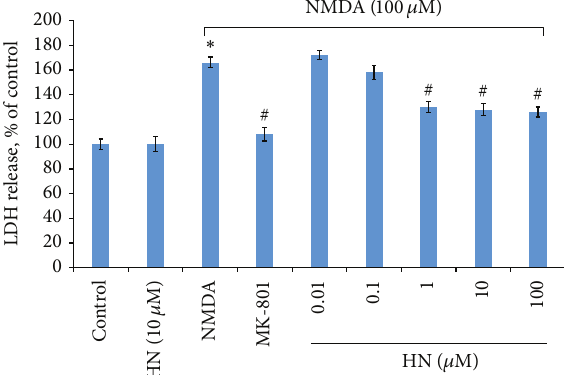
Figure 3: Effect of humanin on NMDA triggered reduction of cell viability in cortical neurons as measured by MTT cell viability assay. Each bar represents mean ± SEM of five independent observations. Statistical significance is at 𝑃 < 0.05 . 𝐹 (8,64) = 2.697 and 𝑃 = 0.013 according to one-way ANOVA analysis. ∗ represents control versus NMDA group ( 𝑃 = 0.032 ); control versus HN (10 𝜇 mol/L), 𝑃 = 0.421 ; # represents NMDA group versus NMDA + MK-801 group ( 𝑃 = 0.026 ) or NMDA + HN (Humanin) group. HN (0.01 𝜇 mol/L), 𝑃 = 0.289 ; HN (0.1 𝜇 mol/L), 𝑃 = 0.036 ; HN (1 𝜇 mol/L), 𝑃 = 0.024 ; HN (10 𝜇 mol/L), 𝑃 = 0.012 ; HN (100 𝜇 mol/L), 𝑃 = 0.021 . ∗ and # mean that there is statistical significance between control and treatment groups.